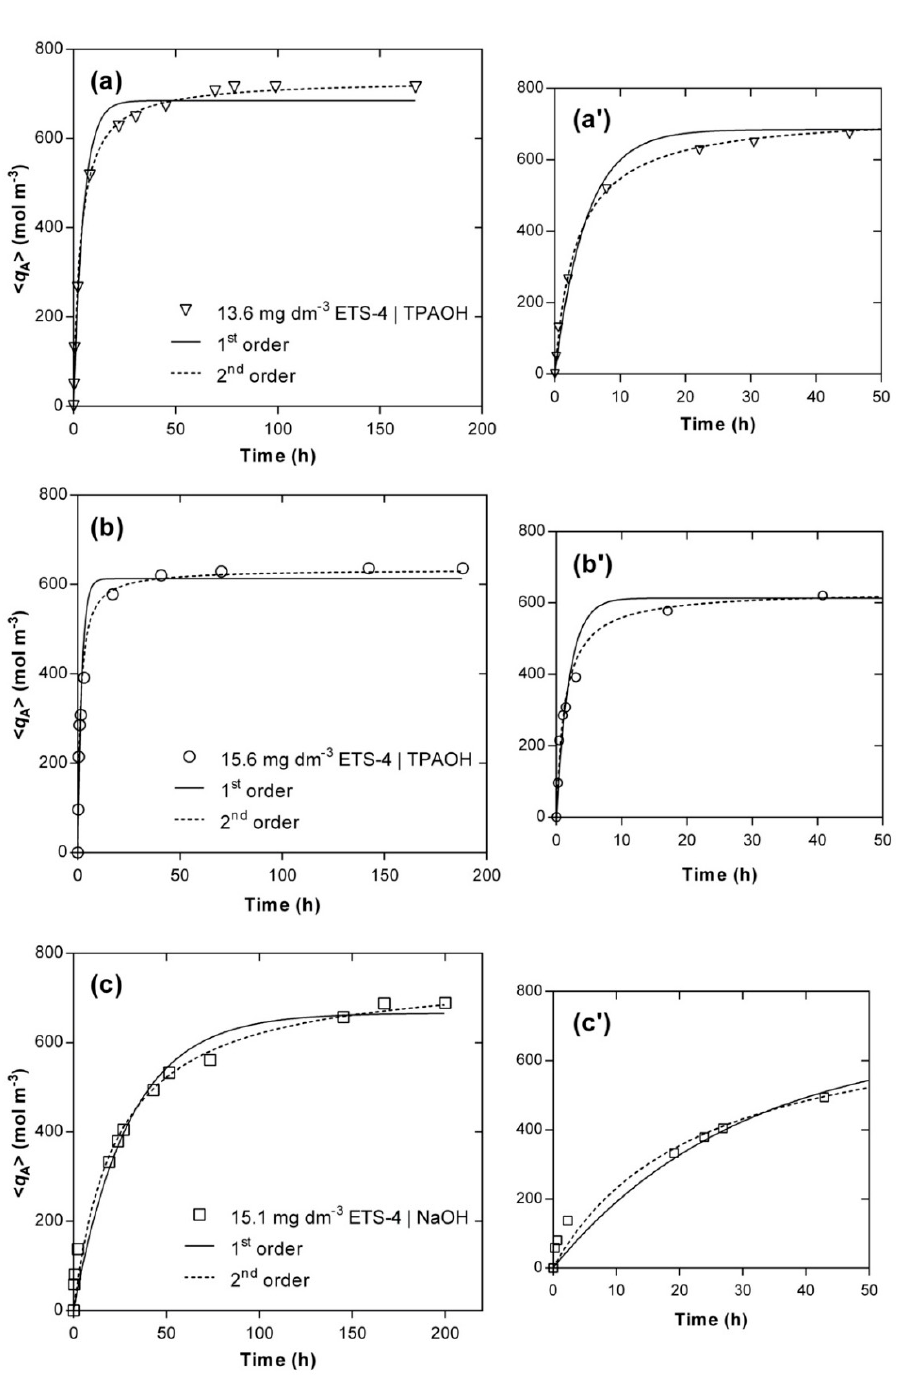
Figure 4. Experimental (symbols) and modelling (lines) results of Hg 2+ concentration in the solid phase versus time. Experimental conditions: ( a ) TPAOH solution, 15.6 g m − 3 of ETS-4 ( ); ( b ) TPAOH solution, 13.6 g m − 3 of ETS-4 ( ▽ ); ( c ) NaOH solution, 15.1 g m − 3 of ETS-4 ( ). On the right side ( a’ – c’ ), the zoom-in for the first 50 h of each system is shown.